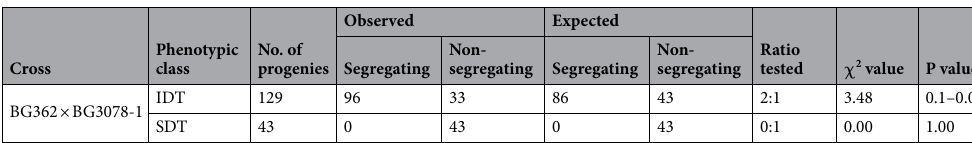
Table 2. Segregation for stem growth habit in F 3 of a chickpea cross involving indeterminate and semi- determinate parents. IDT indeterminate, SDT semi-determinate.